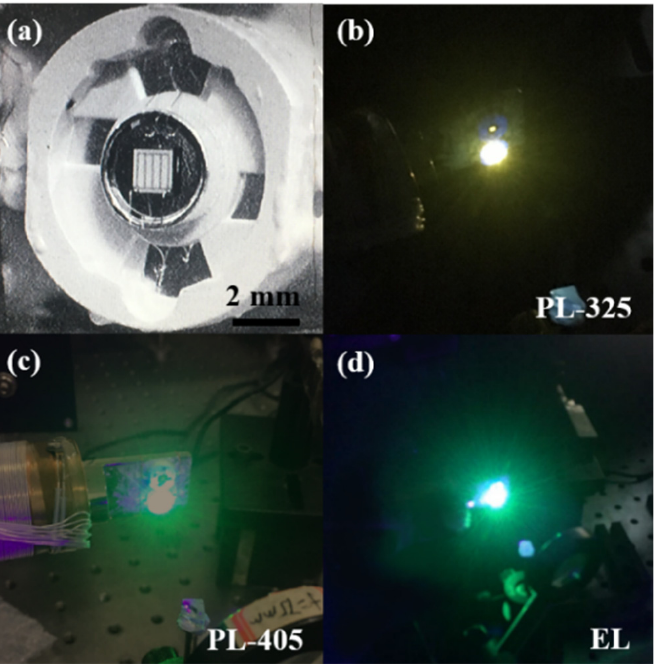
Figure 1. ( a ) Enlarged image of the green LED chip. ( b – d ) Luminescent image of the green LED chip under excitation by 325-laser, 405-laser, and current, respectively. The spectra excited by 325-laser and 405-laser are marked as PL-325 and PL-405, respectively.